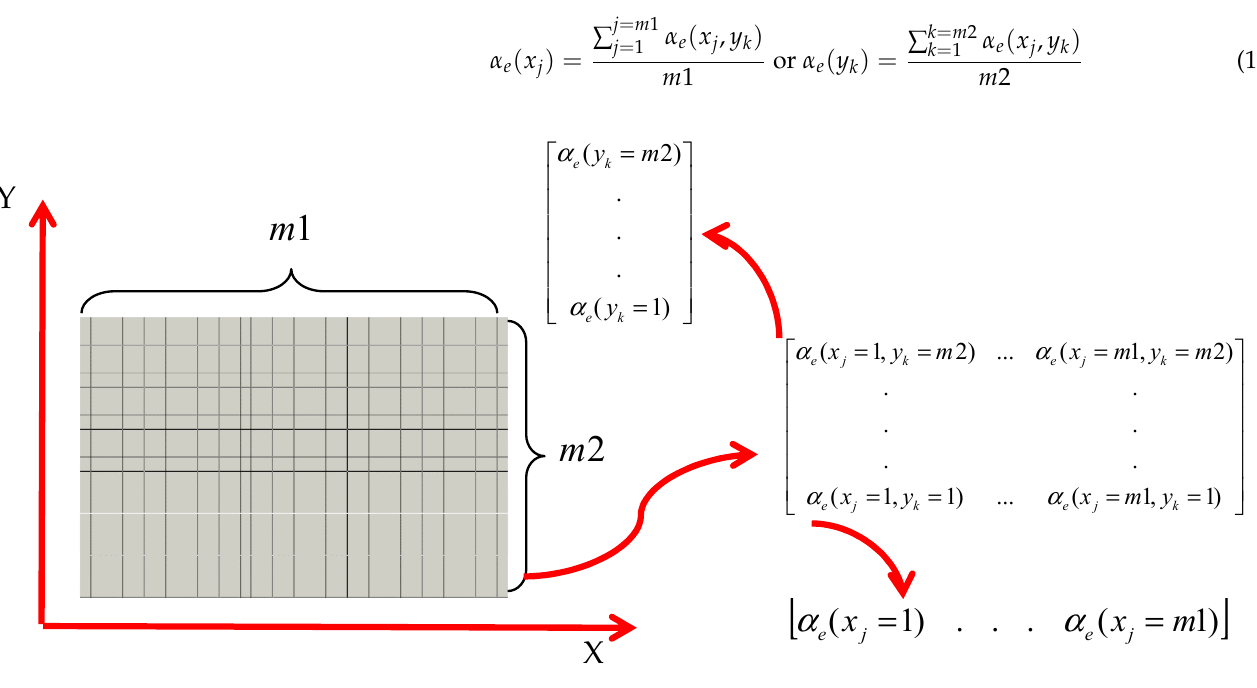
Figure 4. Thickness-variation constraint.